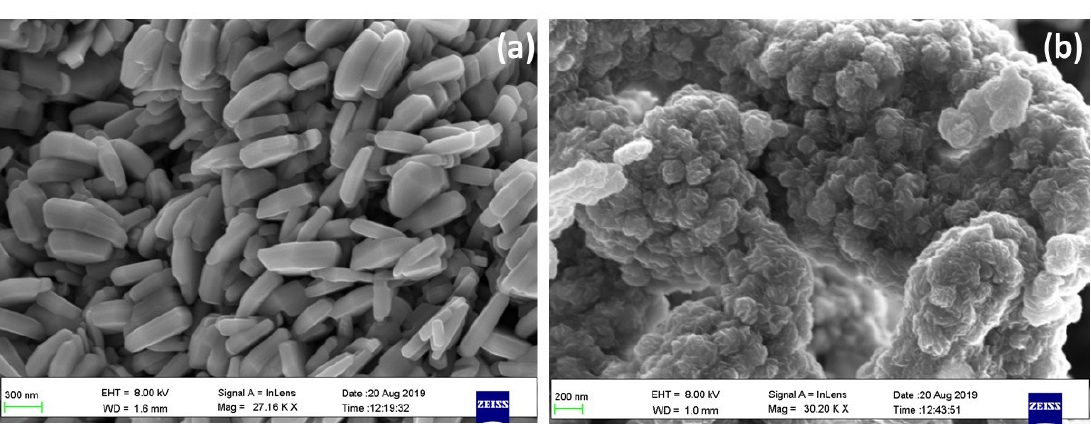
Figure 4. FESEM images of ( a ) bulk fabricated CuO and ( b ) PSE-capped Cu 2 O/CuO materials fabricated by the aqueous solution combustion approach.